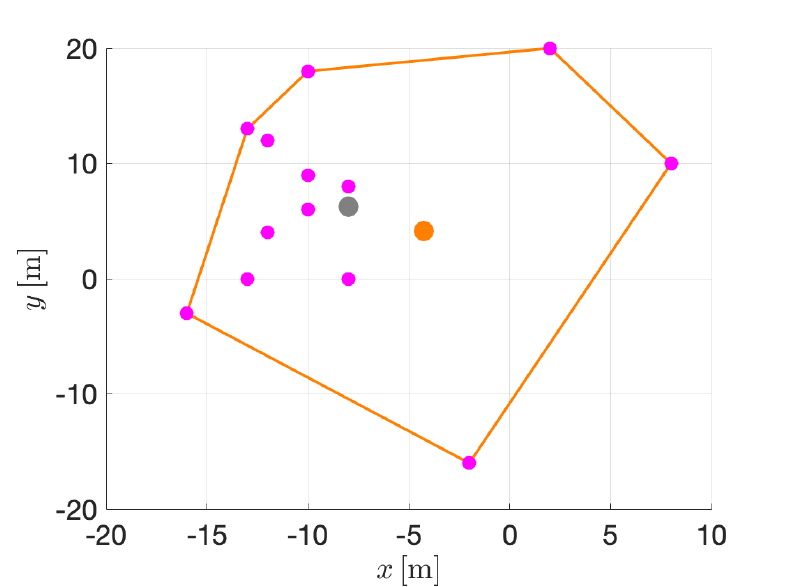
Figure 6. Central point of a cloud of targets by estimation of the convex-hull center (in orange) and by estimation of the center of mass (in gray).